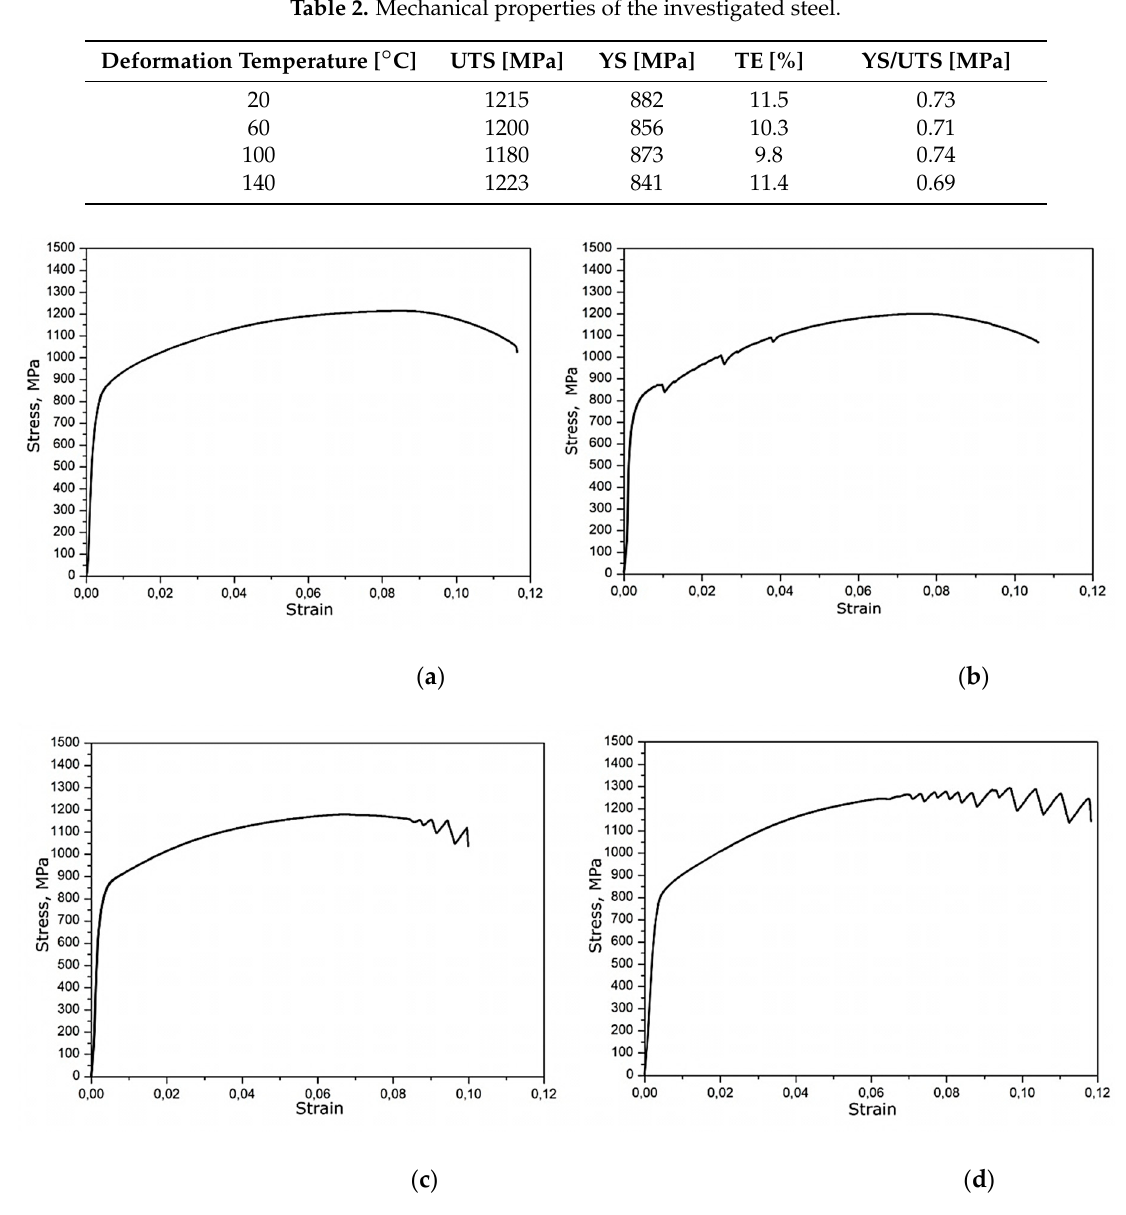
Figure 2. Engineering stress-strain curves of investigated steel registered at: (a) 20 ° C, (b) 60 ° C, (c) 100 ° C, and (d) 140 ° C .